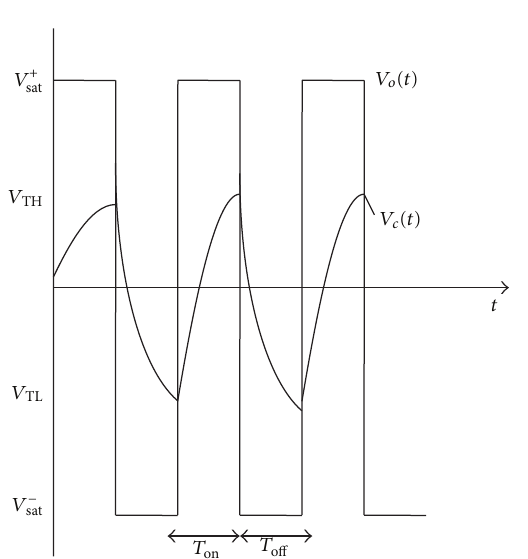
F 6: Equivalent circuit of OTRA constructed with